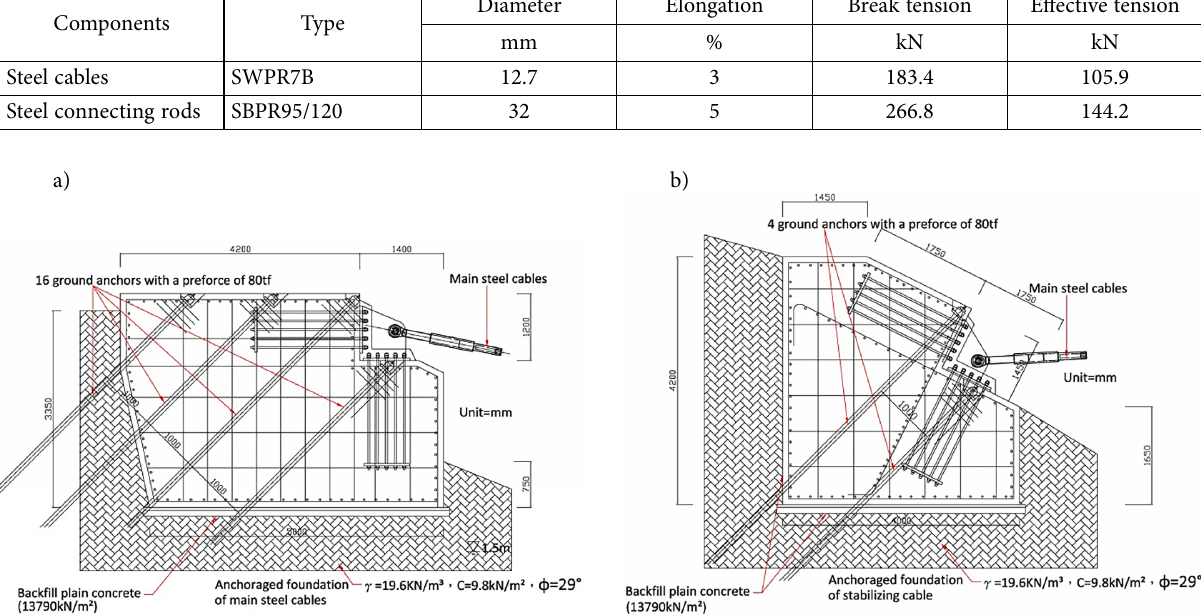
Figure 5. Cross-sections of the anchor foundations of: a – main steel cable; b – stabilizing